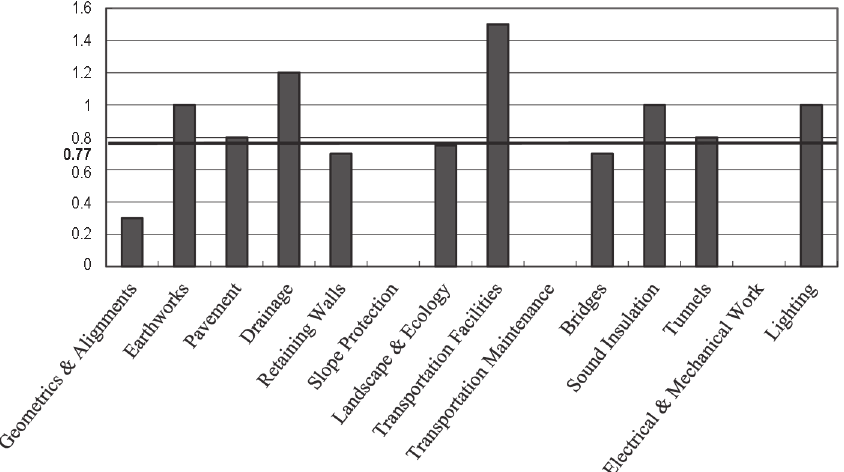
Fig. 2. Average difficulty of 14 design disciplines